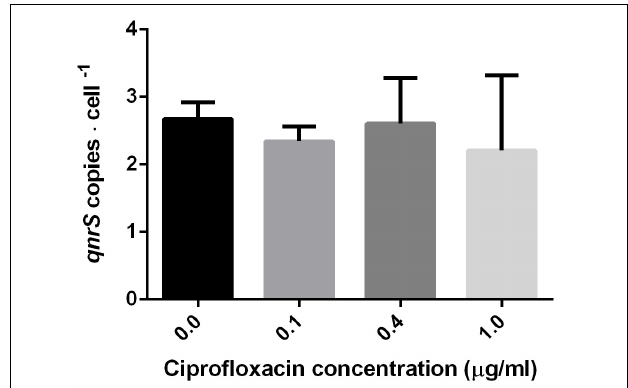
FIGURE 2 | Estimated copy number of pKPSH213.55 plasmids per bacteria purified from cultures at mid-log phase cells grown in media containing different ciprofloxacin concentrations (0, 0.1, 0.4, and 1.0 µ g ml − 1 ). Plasmid copy number was inferred by normalizing qPCR-based qnrS copy number to the seven gene copies of 16S rRNA in DH10B. Cells grown in 0 and 0.1 µ g ml − 1 ciprofloxacin were harvested after 2.5 h; cells grown in